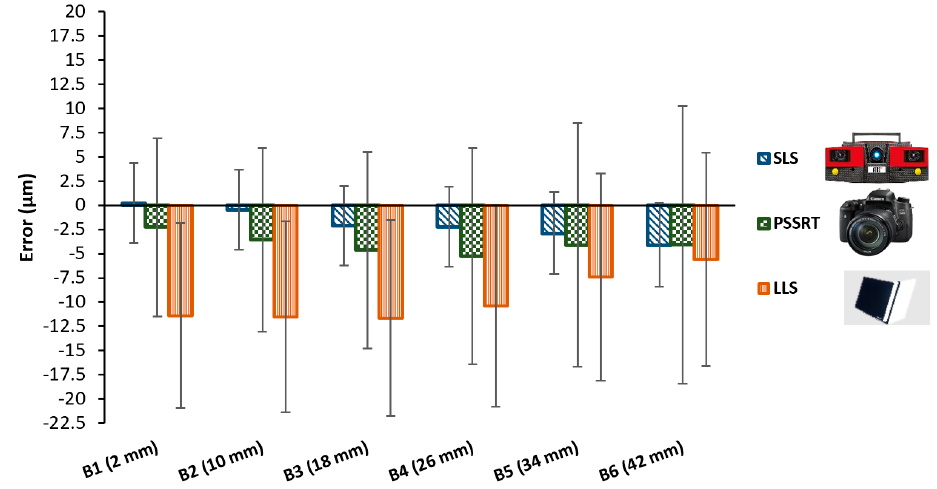
Figure 12. Results obtained considering bidirectional lengths.